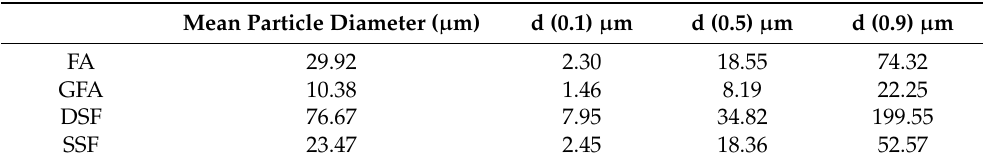
Table 3. Particle size parameters of fly ash before (FA) and after milling (GFA), and silica fume before (DSF) and after the sonication process (SSF).